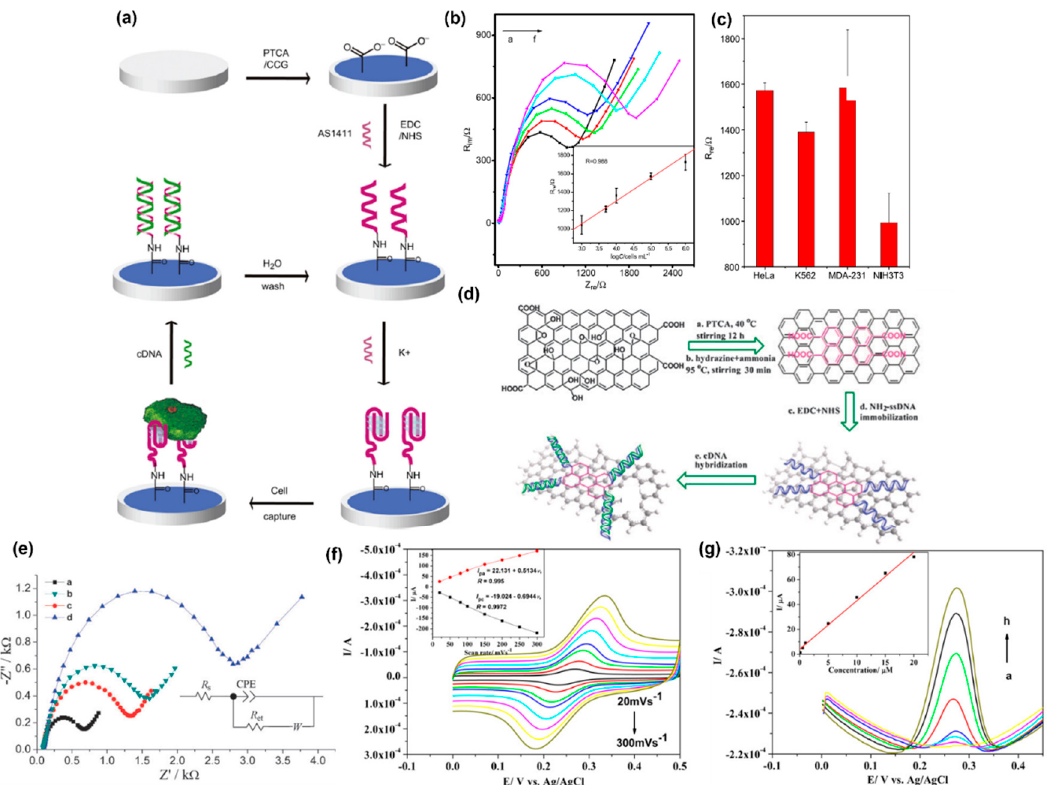
Figure 10. ( a ) Reusable AS1411 / graphene electrochemical aptasensor. ( b ) Electrochemical impedance spectroscopy (EIS) Nyquist plot of the PTCA / CCG modified GCE exposed to HeLa cells which is a